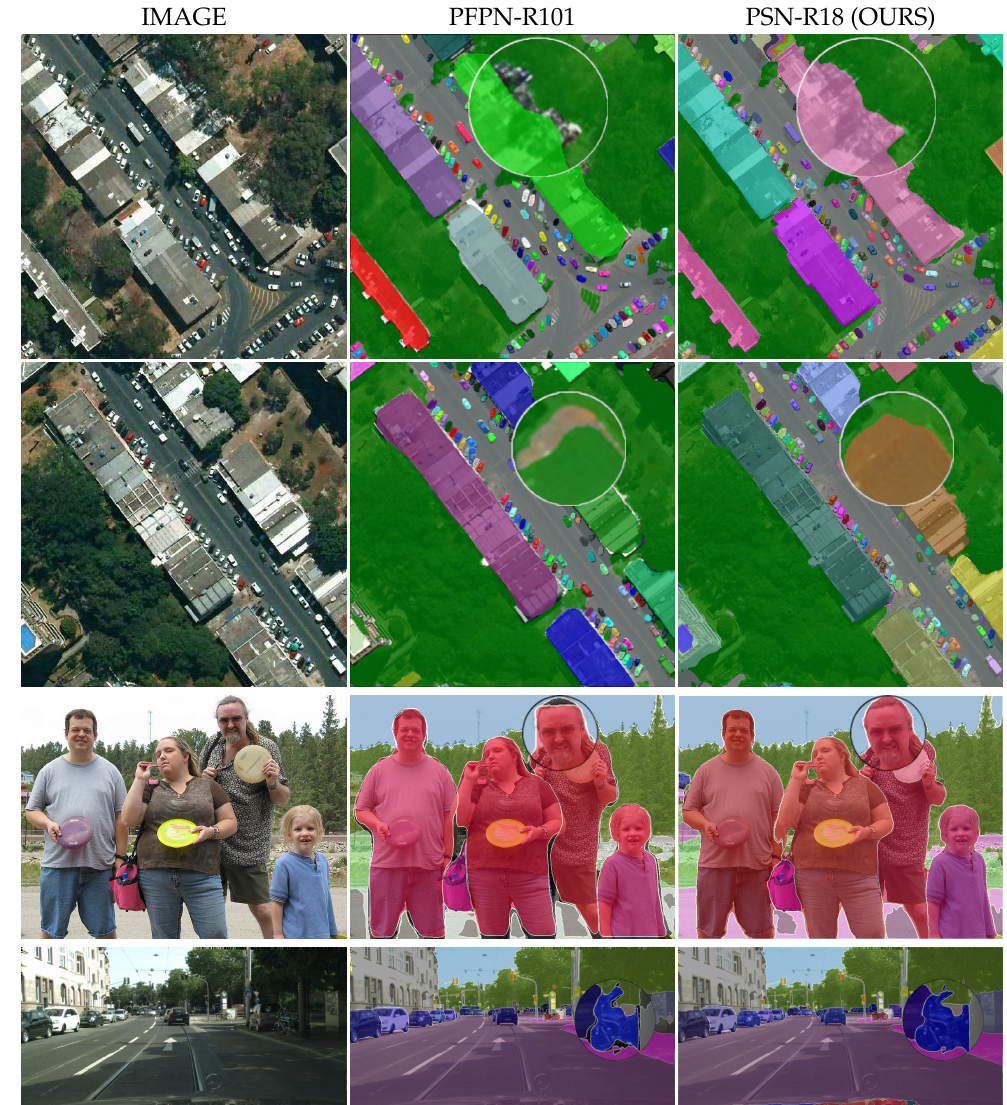
Figure 5. Qualitative comparison between our method (column 3) and Panoptic FPN (column 2) on BSB Aerial dataset (rows 1 and 2), COCO (row 3), and Cityscapes (row 4)